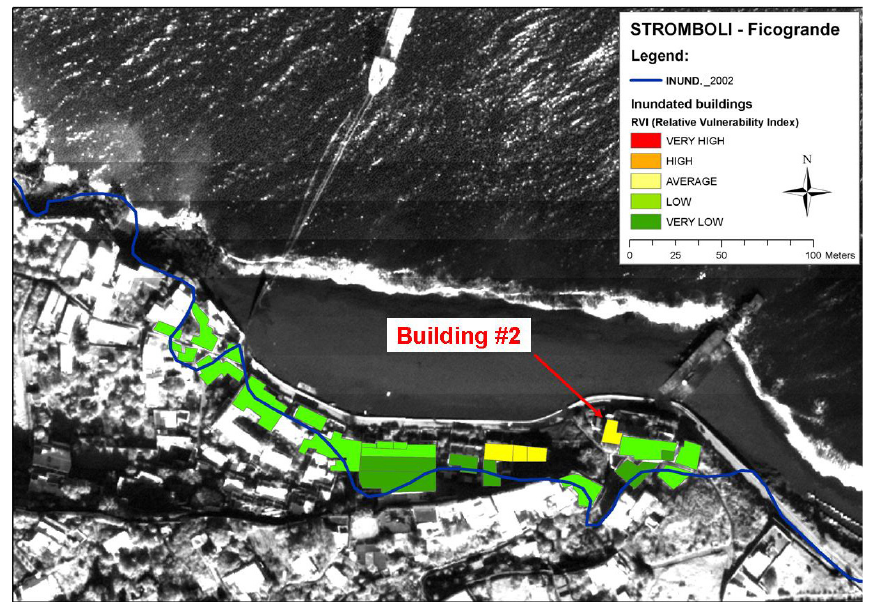
Fig. 5. Vulnerability map of Ficogrande (Stromboli Island). The map layout corresponds to the red frame in Fig. 2. The blue line marks the limit of maximum inundation caused by the 2002 tsunami. Building #2 has been used to validate PTVA-3 Model results. Two pictures of damage suffered by building #2 during the 2002 tsunami are shown in Fig.